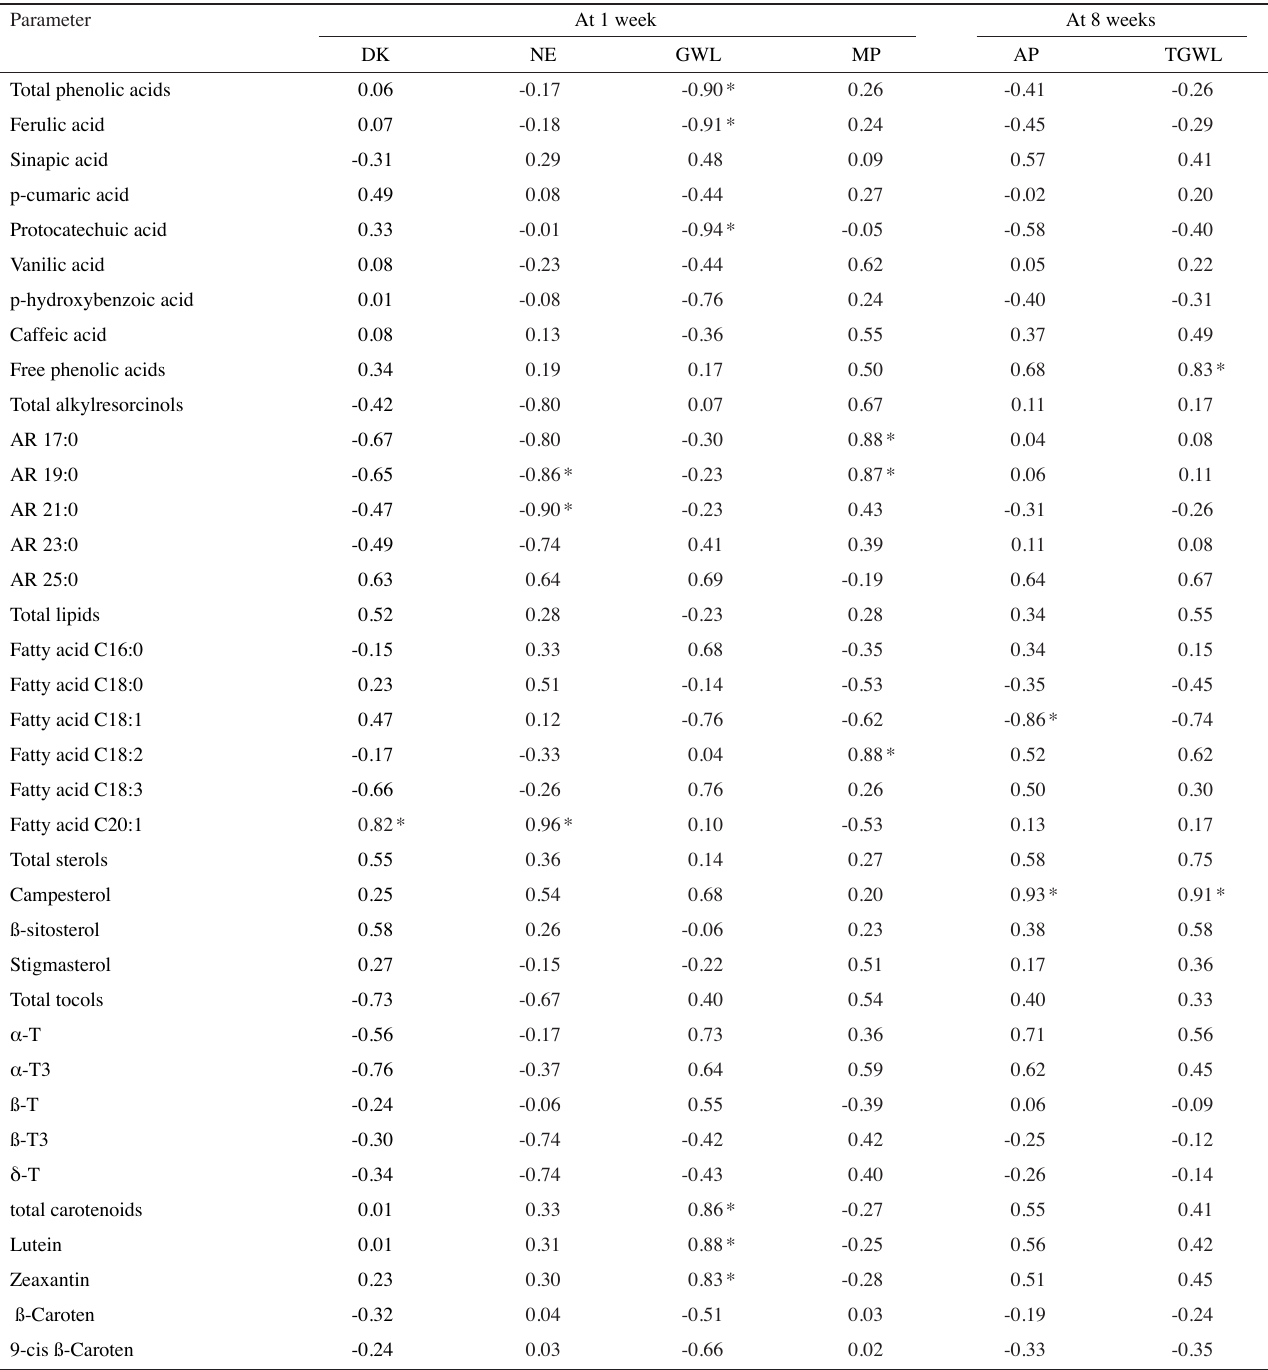
Tab. 3: Correlations between parameters of development of S. granarius and chemical composition.